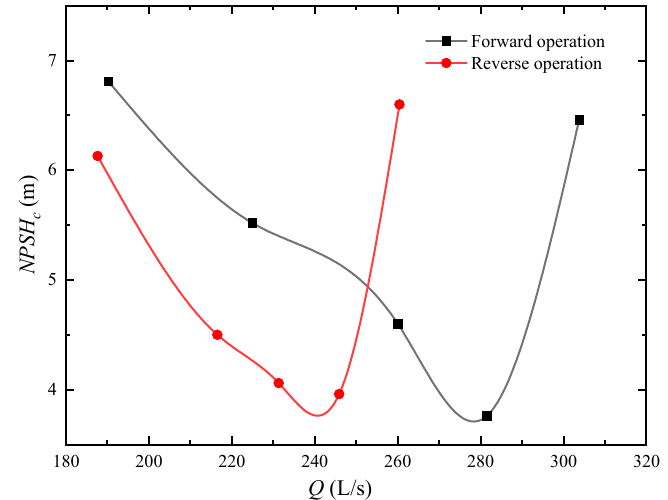
Figure 12. Cavitation characteristic NPSH c — Q / Q d curve of the pump in: ( a ) forward operation; ( b ) reverse operation.